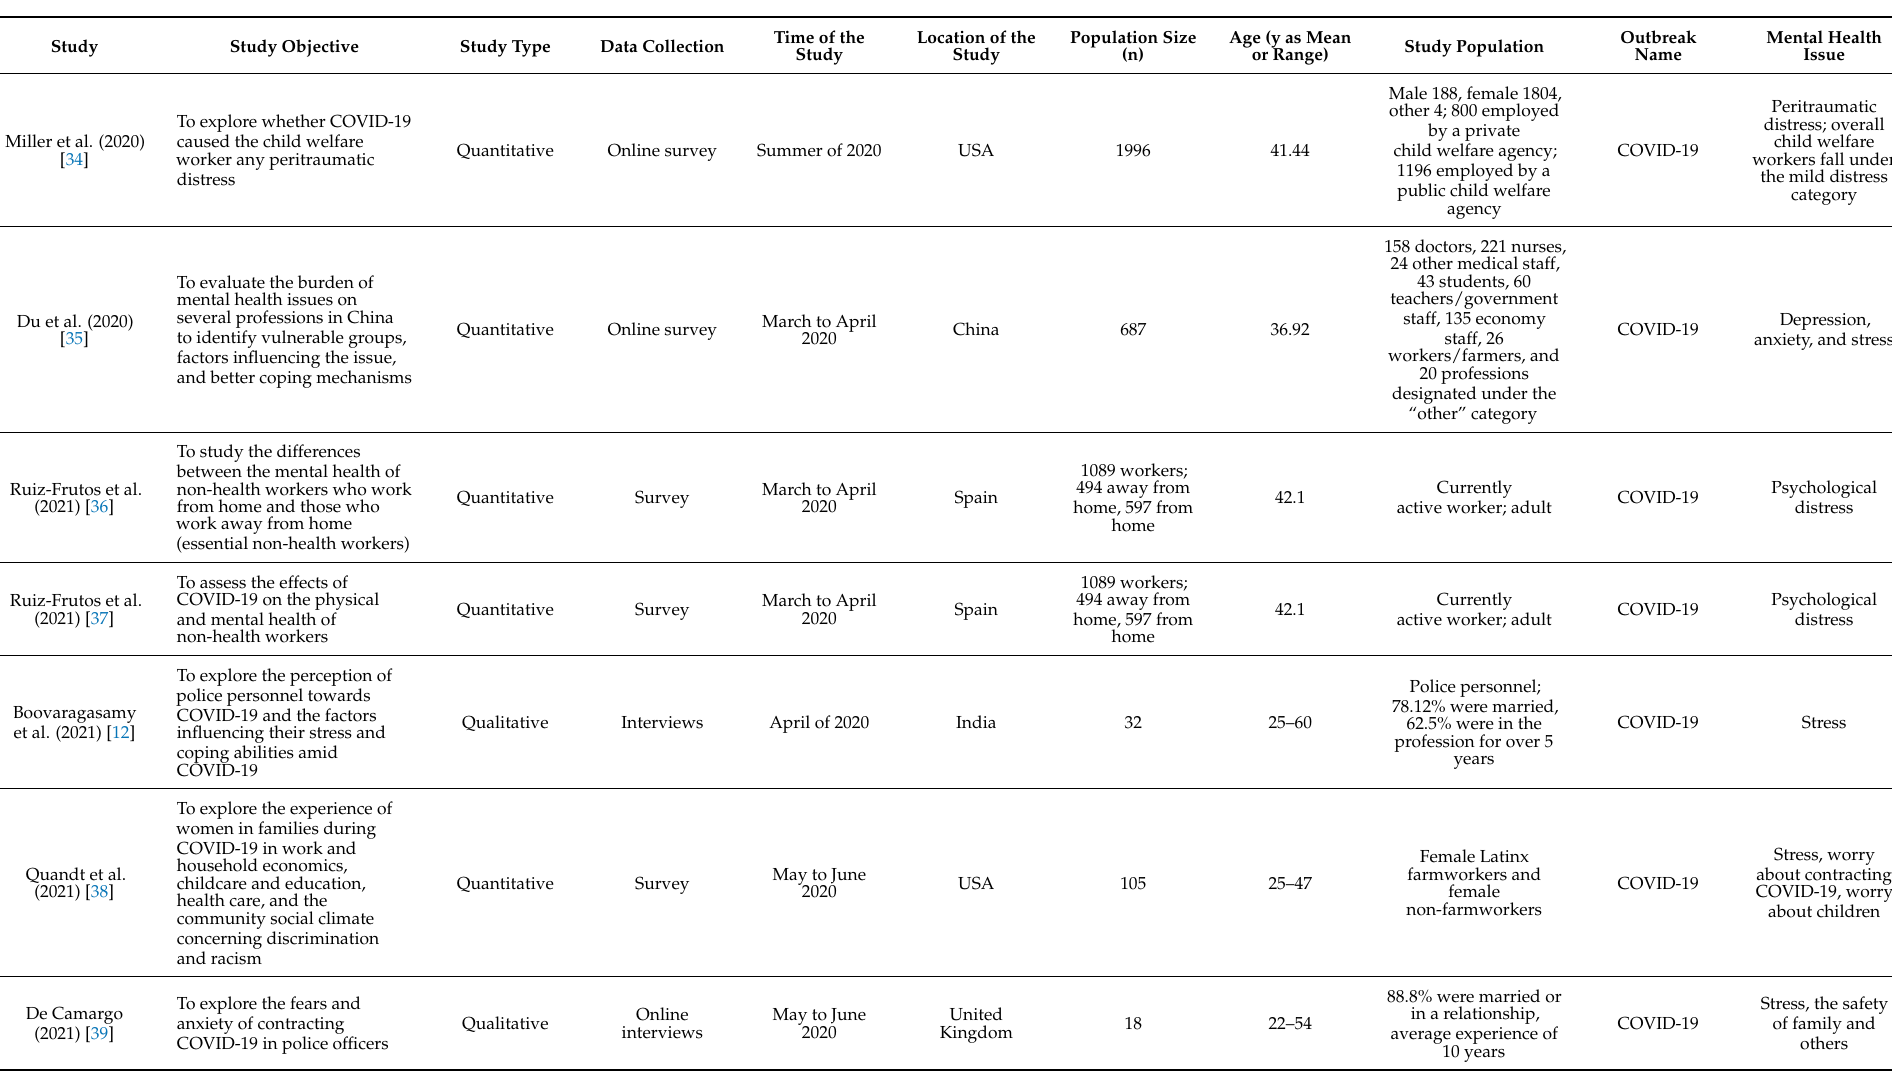
Table 4. Description of study